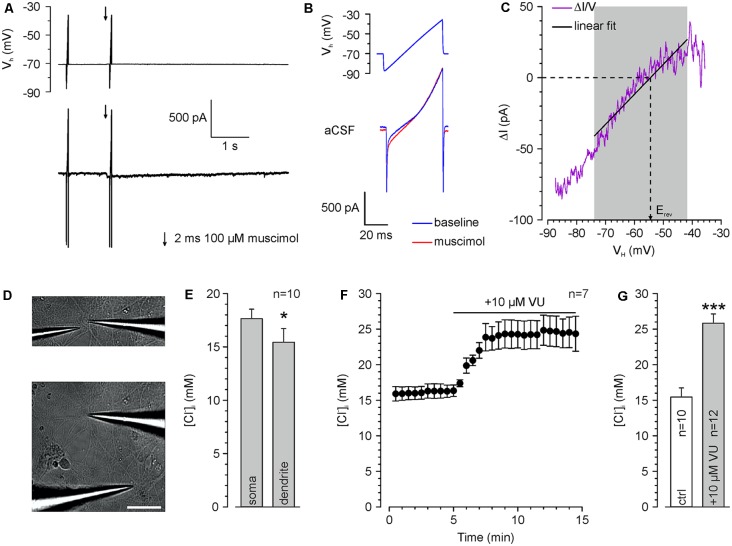
Determination of somatic and dendritic [Cl−]i in whole-cell patch-clamp experiments. (A) Typical current traces upon injection of voltage ramps which are used to determine ECl. The second voltage ramp was applied during the peak of a muscimol response. (B) Voltage ramp and current response is shown in (A) at higher temporal resolution. Note the divergent current amplitude in the presence of muscimol (red trance). (C) Relation between muscimol-dependent current difference (ΔI = IMuscimol − IBaseline) and the holding potential (VH). Erev was determined from a linear fit between 14 and 44 ms. (D) Brightfield pictures of a recorded cell illustrating application pipettes positioned near the soma (upper panel) and at the dendrite (lower panel). Scale bar: 50 μm. (E) Resting [Cl−]i at the soma compared to a dendritic compartment 100 μm apart from the soma center. All experiments were performed under whole-cell conditions with a pipette solution containing 20 mM Cl− ([Cl−]p). Note the significant lower [Cl−]i in the dendrite. (F) Time course of dendritic Erev after inhibition of KCC2 with 10 μM VU 0463271. Note the strong [Cl−]i increase upon KCC2 inhibition. (G) Dendritic [Cl−]i at rest and after VU 0463271 application (≥30 min). Note that VU 0463271 induced a significant increase in [Cl−]i. Bars/data points represent mean ± SEM. *,***Indicate significance levels of p < 0.05 and p < 0.001, respectively.